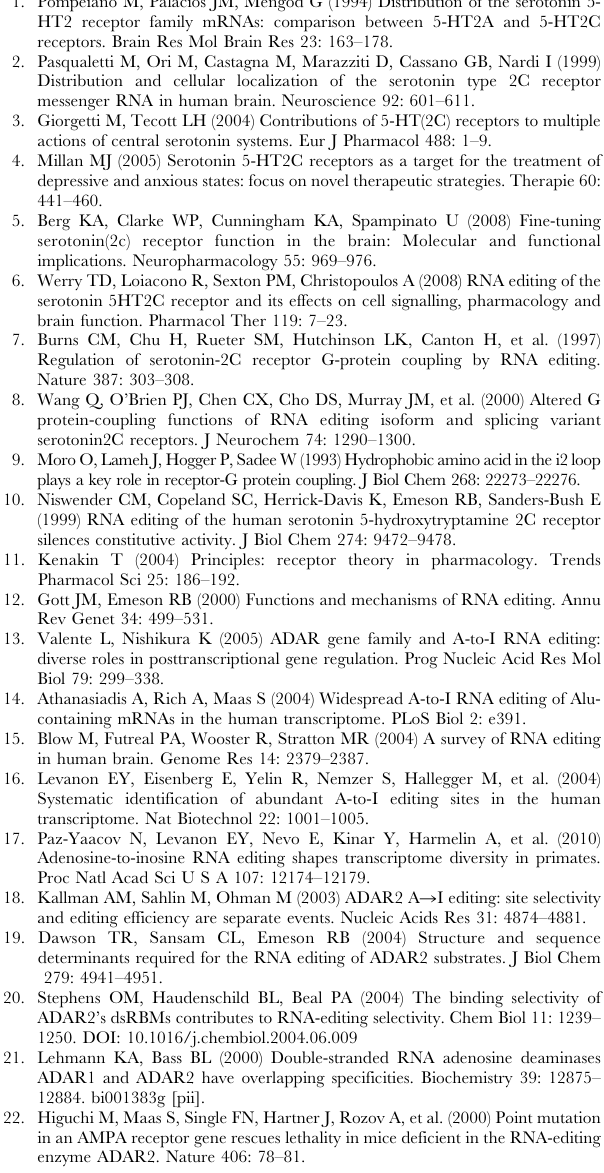
(asterisk marks the best model found in the pooled analysis, see Figure 3). The support is the number of individuals that gave this model as the best-fit model. Table S8 Statistics on the individual best-models for AIC scores in rat. The statistics for AIC is very similar to BIC, and we report here only those models for which the AIC scores behave differently from the BIC scores (changes are in red).